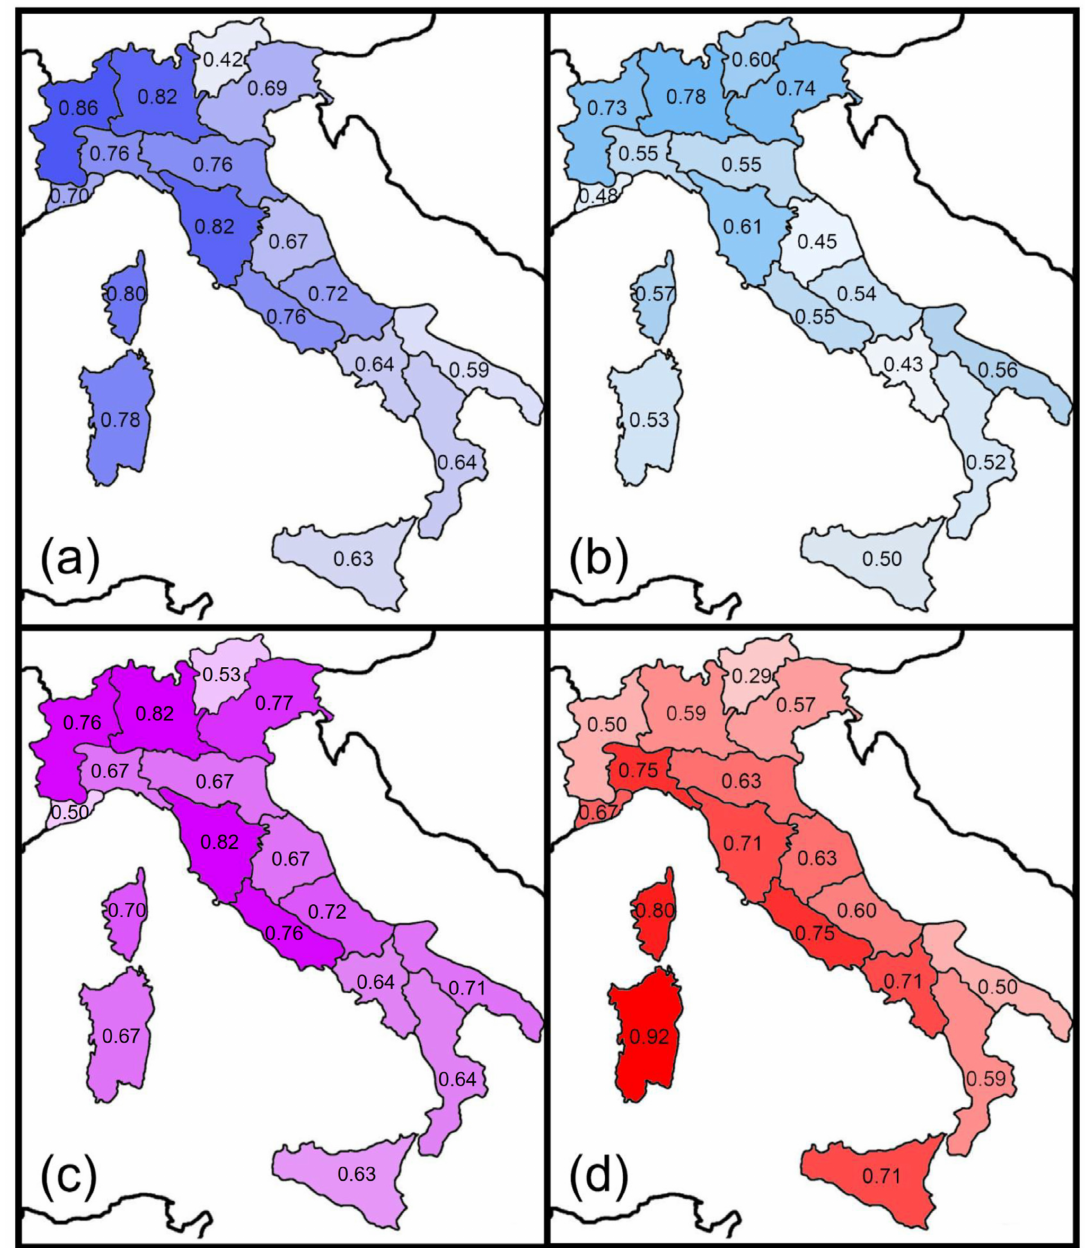
Figure 3. Spatial variations in the Sørensen index of similarity between Italian regions and adjacent ma- jor areas for earwigs: ( a ) Western Europe; ( b ) Central Europe; ( c ) Eastern Europe; ( d ) Northern Africa. In general, the Italian earwig fauna shows three main biogeographical groups of species (Figure 5): (1) species with broad distributions in Europe and the Palearctic re- gion (Cosmopolitan, Holarctic, Asiatic-European, and European chorotypes): (2) species distributed in the Mediterranean area (W-Mediterranean, E-Mediterranean, and Mediter- ranean chorotypes), and (3) endemic species (i.e., species occurring only in Italy, including the islands). Endemics represent a conspicuous component of the total fauna (about 40%), and are present in all regions except Lombardy (region 3), Apulia (region 14) and Sardinia (region 16). The high incidence of endemics suggests a certain role of historical factors as drivers of cladogenetic processes, in accordance with Prediction